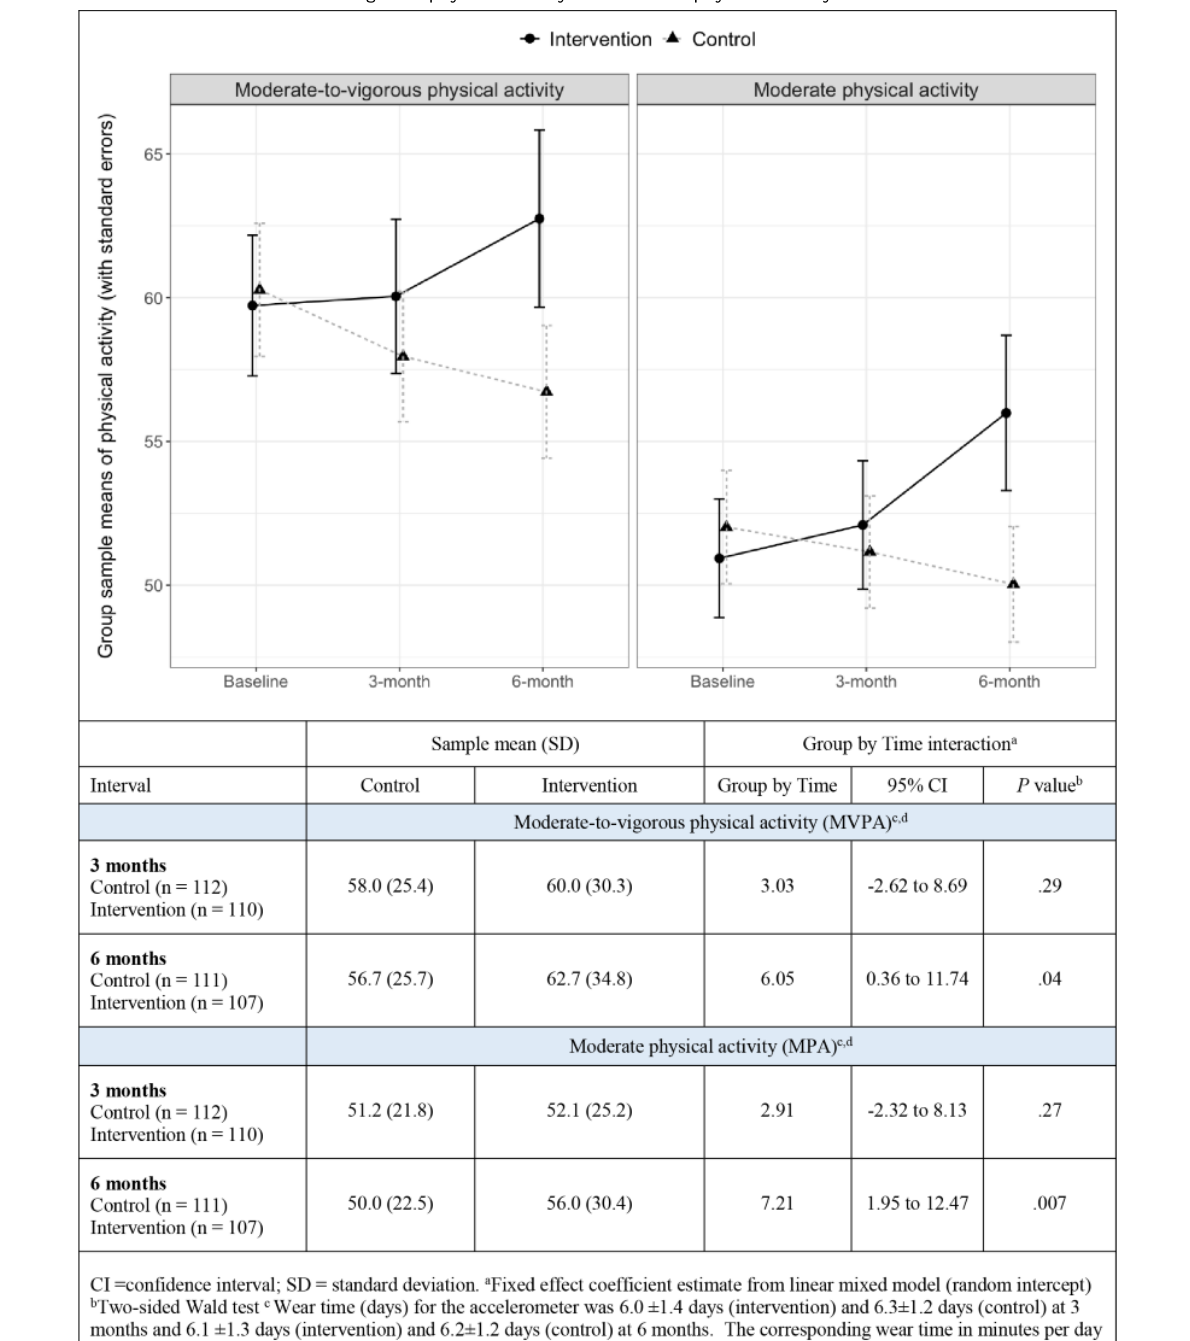
Figure 3. Intervention effect on moderate-to-vigorous physical activity and moderate physical activity at 3 and 6